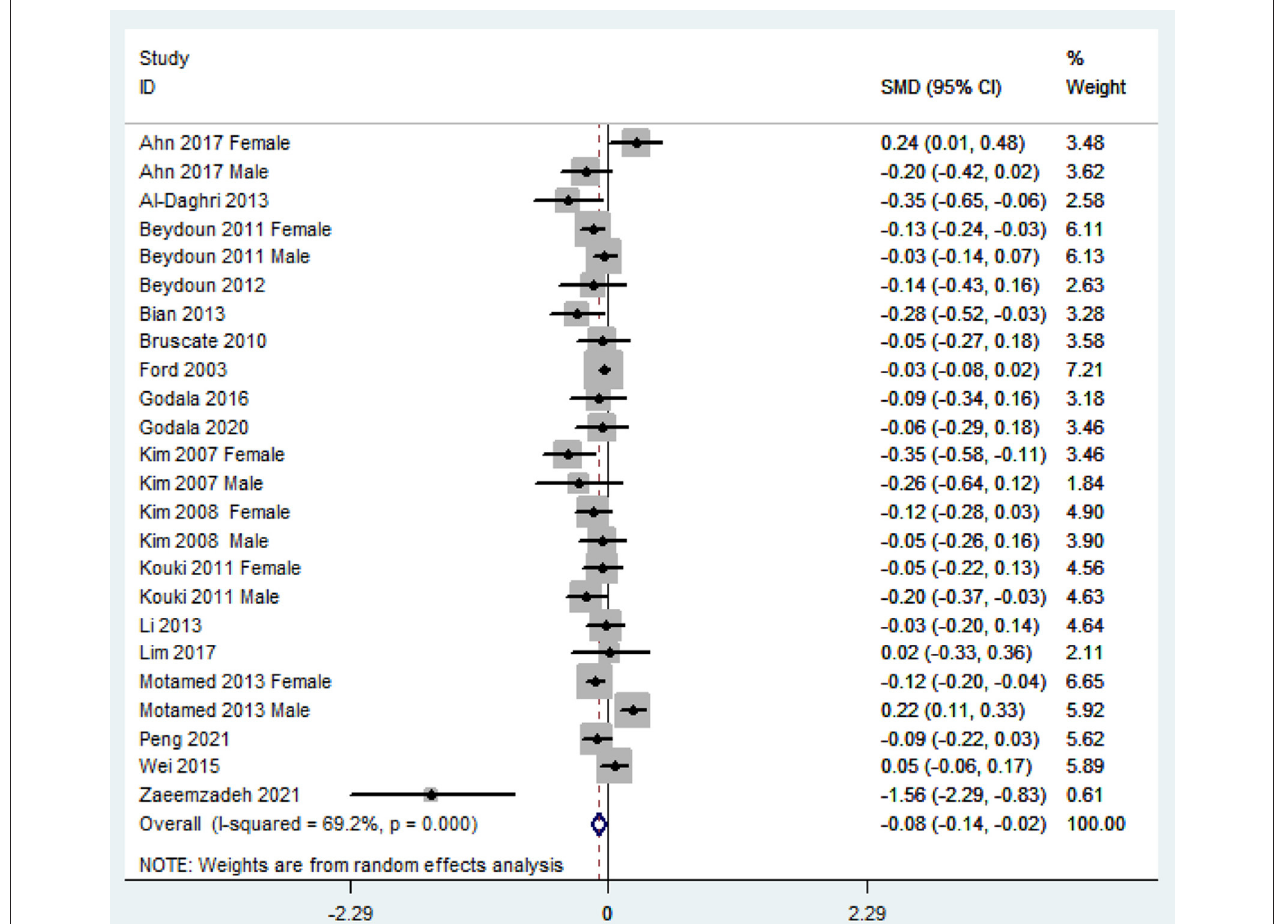
FIGURE 3 | Forest plot of meta-analysis: SMD of dietary vitamin E level for MetS vs. control subjects.